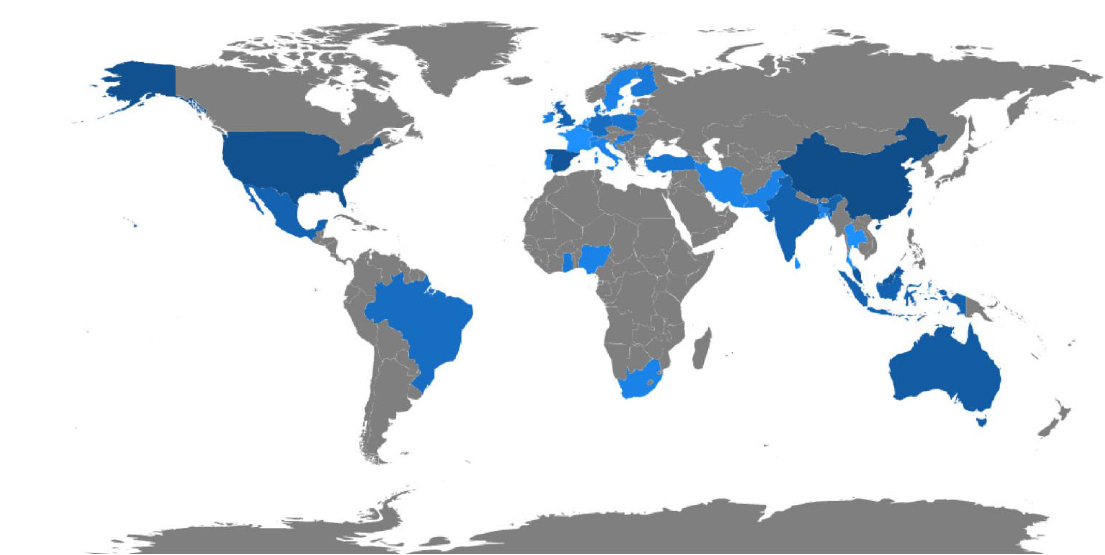
Figure 5. Scientific production by